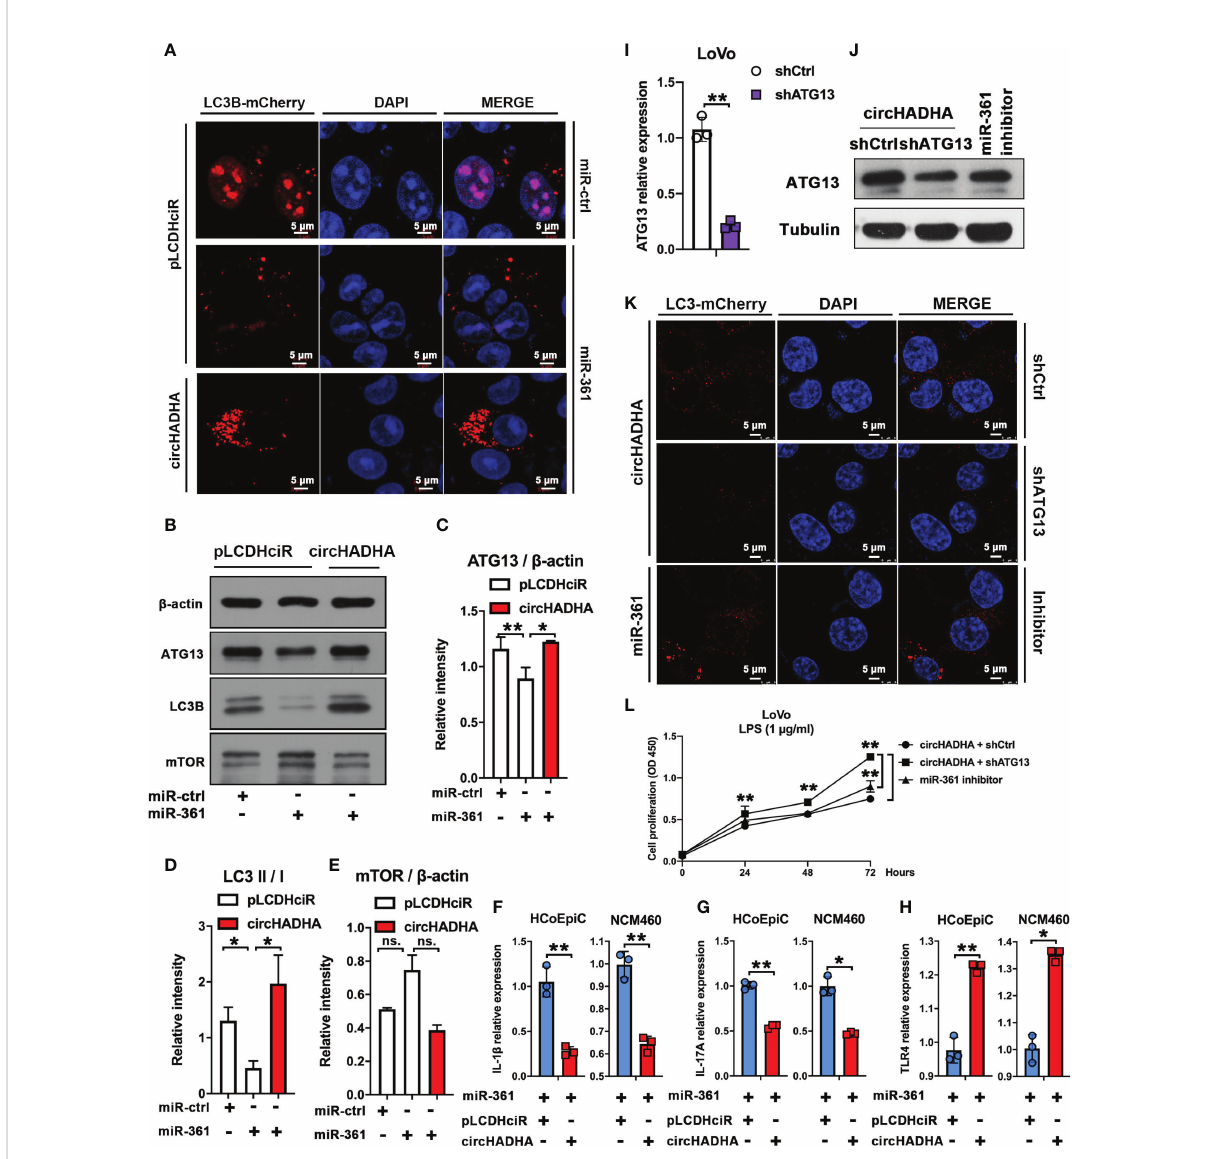
FIGURE 6 circHADHA regulated autophagy mediated by miR-361 and ATG13. (A) The LC3B-mCherry-based autophagy assays in HCoEpiC. In pLCDHciR control cells, miR-361 signi fi cantly suppressed autophagy by reducing the production of LC3B-positive autophagosomes with LPS treatment. Overexpression of circHADHA promoted autophagy in the presence of miR-361 treated with LPS in HCoEpiC. mCherry represented LC3B- positive autophagosomes. Cell nuclei were labeled with DAPI. (B) The measurement of autophagy-related protein expression by Western blot in LPS-injured HCoEpiC. In the absence of circHADHA, miR-361 inhibited ATG13 and LC3B compared to miR-control. Overexpression of circHADHA increased the expression of ATG13 and LC3B compared to pLCDHciR control transfected with miR-361. The expression of mTOR did not show signi fi cant changes with circHADHA/miR-361 treatment. (C) The intensity of ATG13 compared to b -actin from Western blot. (D) The intensity ratio of LC3B II to I from Western blot. (E) The intensity of mTOR compared to b -actin from Western blot. (F – H) The in fl ammatory cytokines were validated in colon epithelial cells with LPS treatment. (F) The IL-1 b expression was downregulated in circHADHA-overexpressing colon cancer cells compared with control with miR-361 treatment. (G) The expression of IL-17A was downregulated in circHADHA- overexpressing colon cancer cells compared with control with miR-361 treatment. (H) Overexpression of circHADHA upregulated the expression of TLR4 transfected with miR-361. (I) The generation of ATG13 knockdown (shATG13) in LoVo cells. (J) The expression of ATG13 was decreased by ATG13 knockdown at the protein level compared to the treatment of shControl or miR-361 inhibitor in circHADHA- overexpressing LoVo cells. (K) The LC3B-mCherry-based autophagy assays in LoVo cells. ATG13 knockdown reduced LC3B-positive autophagosomes in circHADHA-overexpressing LoVo cells compared to the transfection of shControl or miR-361 inhibitor with LPS treatment. mCherry represented LC3B-positive autophagosomes. Cell nuclei were labeled with DAPI. (L) The measurement of cell viability was performed by CCK-8 assay. Overexpression of circHADHA inhibited proliferation compared with control in LPS-induced LoVo colon cancer cells. ATG13 knockdown increased proliferation in circHADHA-overexpressing LoVo cells compared to the transfection of shControl or miR-361 inhibitor with LPS treatment. Three independent experiments were performed. ** P < 0.01; * P < 0.05; ns, no signi fi cant